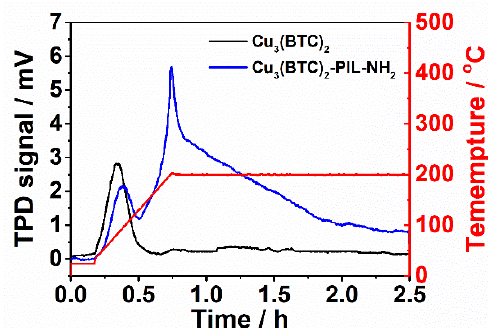
Figure 6. CO 2 TPD response curves for Cu 3 (BTC) 2 and Cu 3 (BTC) 2 -PIL-NH 2 . Red line in the figure refers to the temperature profile for desorption.